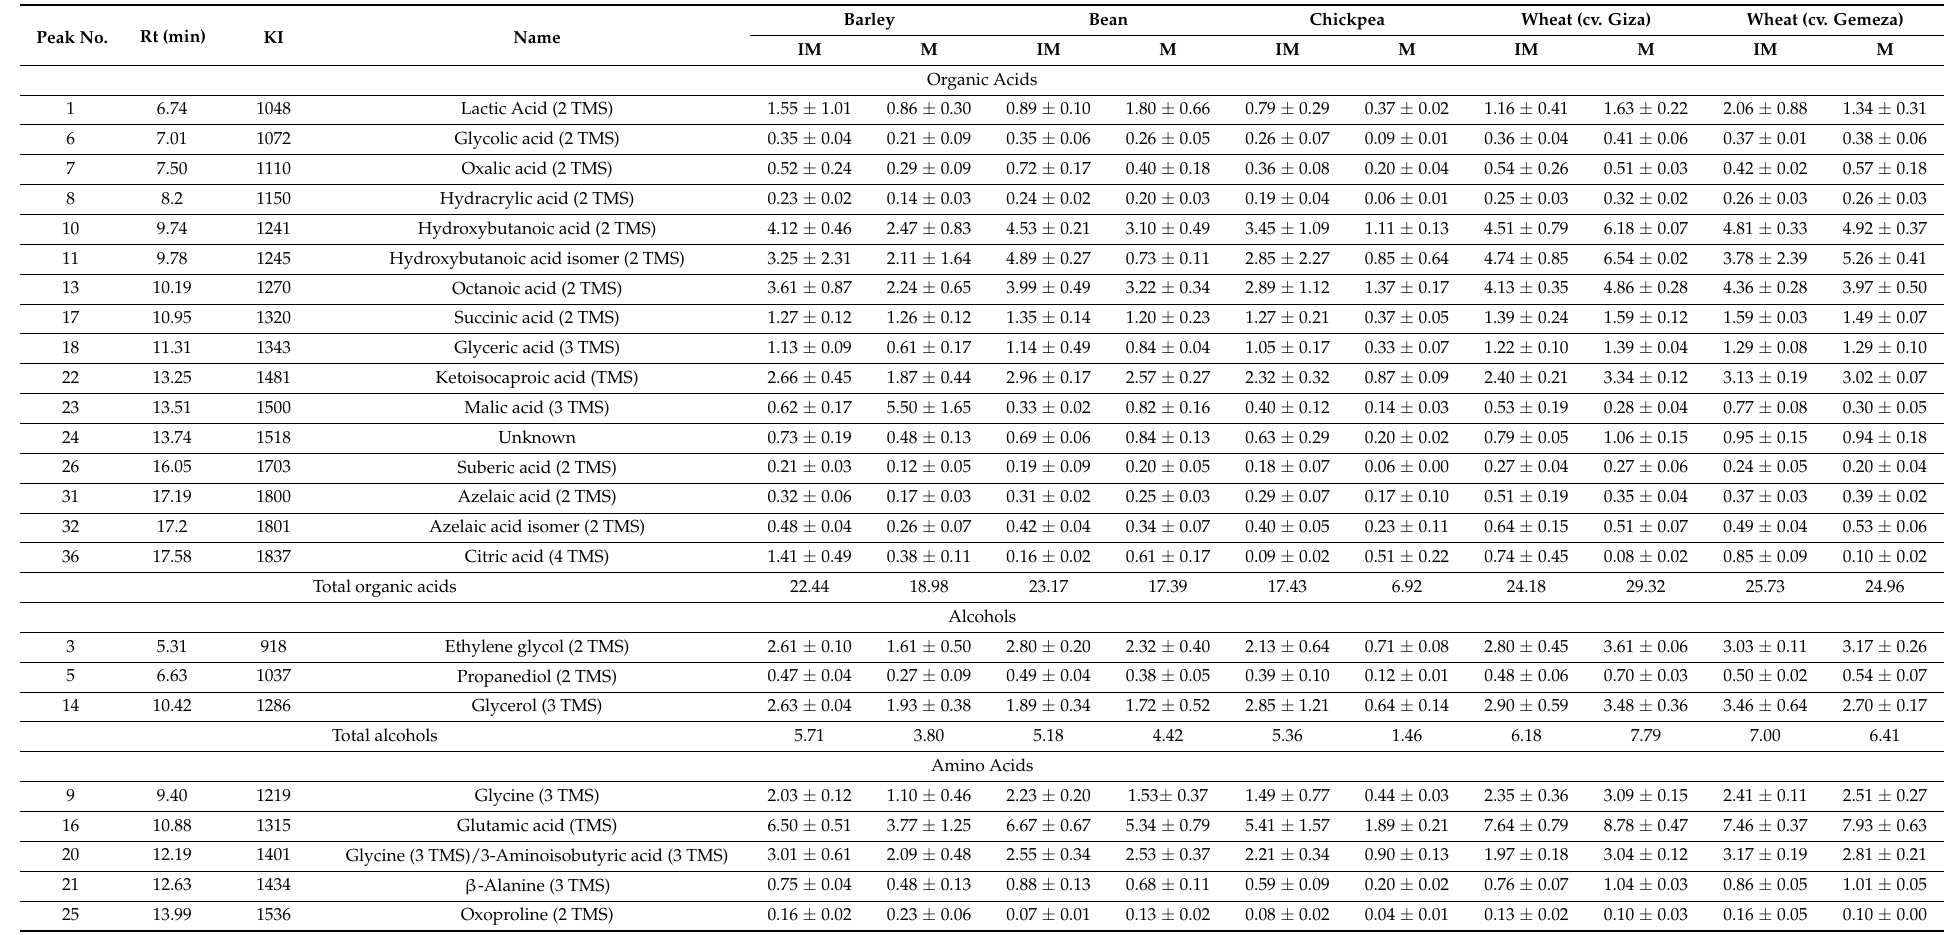
Table 2. Silylated primary metabolites expressed as the relative percentile of the total peak areas ± std. deviation, as analyzed using GC-MS from seeds at different maturity stages with results expressed as ( n = 3). For codes, refer to Table